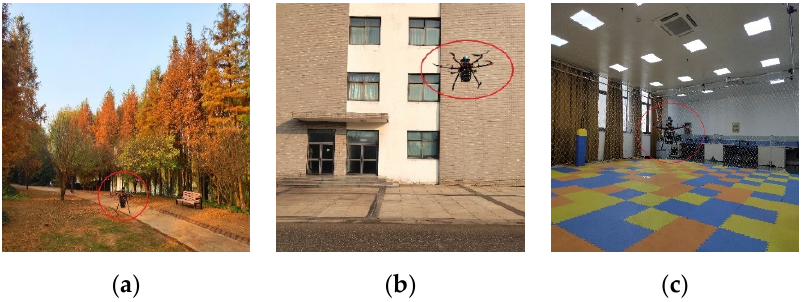
Figure 7. Images of the UAV in flight in different environments. ( a ) The drone flying in the woods; ( b ) The drone flying adjacent to high-rise buildings; ( c ) The drone flying in an indoor environment. We used the manual attitude mode to fly the UAV adjacent to high-rise buildings. The experimental results are shown in Figure 8, and were transformed by coordinates and units. The data shown in Figure 8a–d were calculated in real time through the embedded board (the details are described in Sections 3 and 5.2.2). These data were stored in the FDR. The trajectory was obtained by simultaneously transmitting the position data from the onboard RTK system and the position data from the embedded board to a station on the ground through a wireless link. The number of satellites is shown at the top of Figure 8a. The area that is marked by red ellipses in Figure 8a shows the trajectory when the number of satellites is less than six, and is enlarged, as shown in Figure 8b. It can be seen that the position data from the onboard RTK system, which depend on a GNSS signal, starts to drift and jump, while the position estimated by the fusion algorithm remains stable. In Figure 8c, the horizontal axis represents longitude and the vertical axis represents latitude. The data shown in Figure 8d were obtained by sending the position of RTK and MSDF to the ground station computer at the same time, the red line represents the position of the RTK, and the blue line represents the fused position. The areas that were marked by red ellipses in Figure 8c,d show the stage of drift from another perspective.